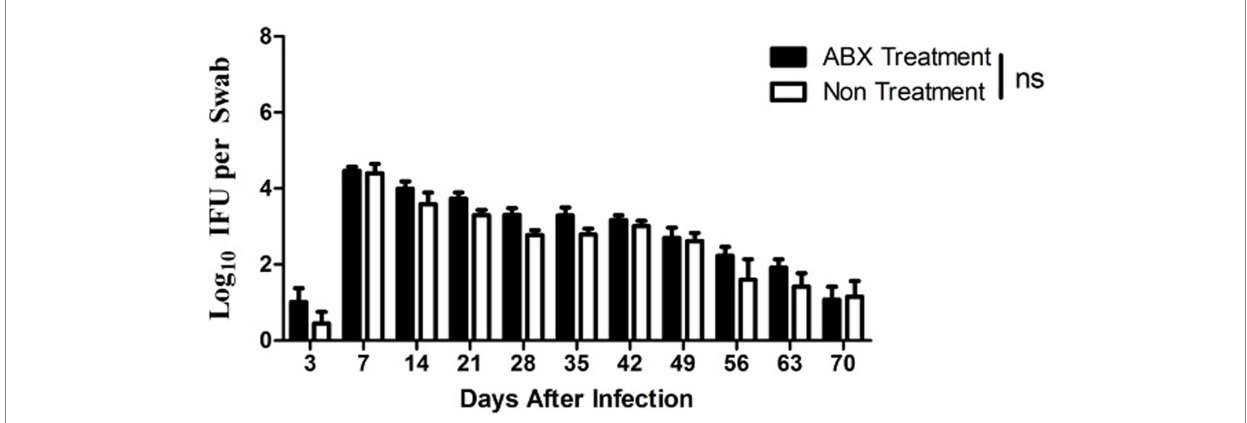
FIGURE 5 Oral antibiotics treatment did not alter the C. muridarum colonization in the gut. Female DBA2/J mice without (Non, n = 20) or with (ABX, n = 29) oral antibiotics treatment was intravaginally infected with C. muridarum as described in Figure 1 legend. Live organism shedding was monitored from rectal swabs on days 3, 7 and weekly thereafter as shown along X -axis. The live organisms recovered (Log10 IFUs per swab) were shown along Y axis. Note that significant shedding was similarly detected in all mice throughout the experiment regardless of the oral antibiotics treatment ( p > 0.05, Wilcoxon for comparing area under curve).